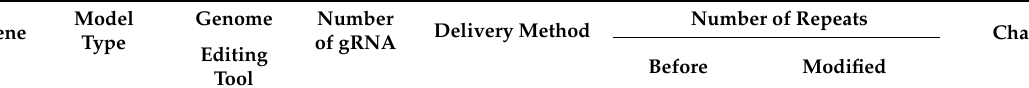
Table 2. Summary of polyQ disease models created using genome-editing